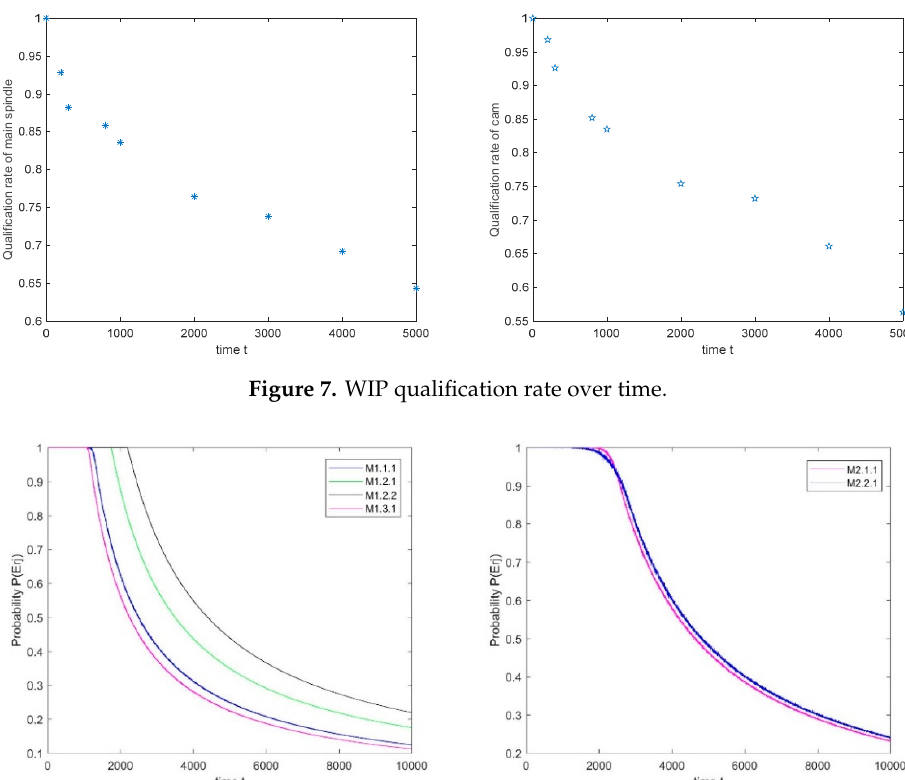
Figure 7. WIP qualification rate over time.